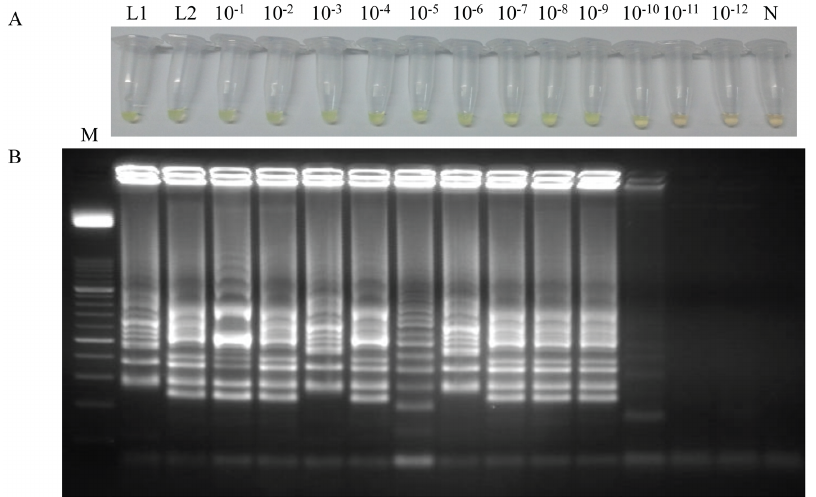
Figure 5. Sensitivity assessment of the LAMP assay for Loaloa performed with a heating block using simulated human blood samples spiked with serial dilutions of genomic DNA by the addition of SYBR Green I (A) or by visualization on agarose gel stained with ethidium bromide (B). Lane L1: genomic DNA from Loa loa (5 ng) as positive control; lane L2: human blood sample spiked with 5 ng of genomic DNA from Loa loa ; lanes 10 2 1 –10 2 12 : human blood samples spiked with 10-fold serially dilutions; lane N: negative control (no DNA template). Lane M: 50 bp DNA ladder (Molecular weight marker XIII, Roche).